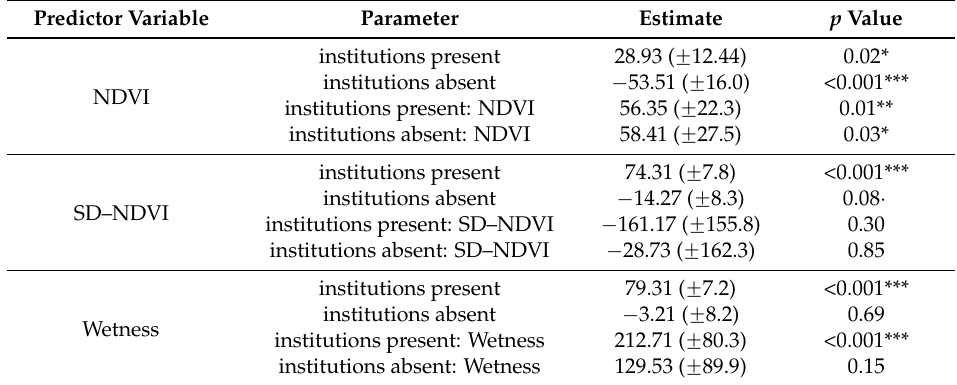
Table 3. Results of quantile regression for tree density (tau = 0.95) in the villages with presence and absence of the local forest institutions.